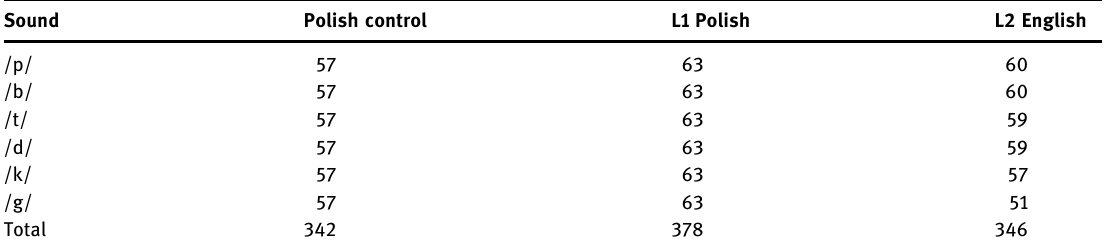
Table 1: Number of tokens